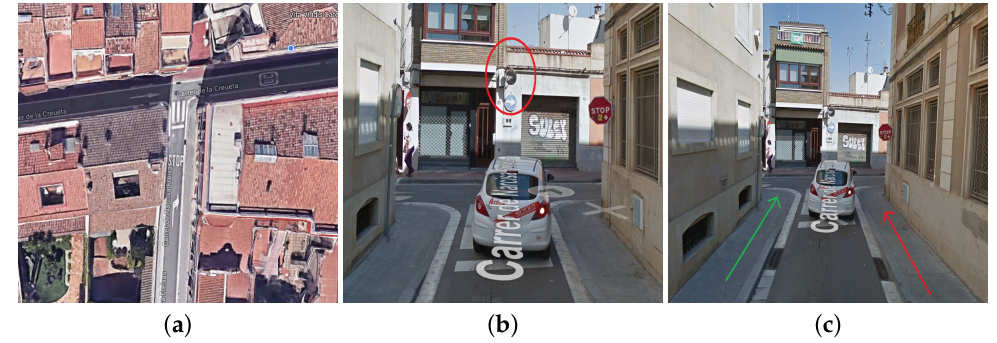
Figure 9. ( a ) Aerial view of the corner under study; ( b ) drivers’ focus of attention; ( c ) recommendations for use represented by